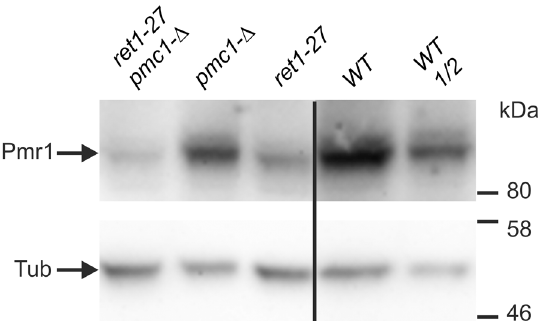
Fig 6. Effect of inactivation of PMC1 on the level of Pmr1 in the ret1-27 mutant strain and in the strain bearing the RET1 wild-type allele. Proteins from cell lysates were resolved by SDS PAGE and transferred to nitrocellulose membrane, which was then divided in two parts at the level of the 80 kDa marker band. The upper part was stained with antiserum against H . polymorpha Pmr1, while the lower part was stained with antibody against tubulin used as a loading control. ret1-27 pmc1- Δ , the 64MA70QA- Δ pmc strain; pmc1- Δ , the 64MA70Q-RET- Δ pmc strain; ret1-27 , the 64MA70QAL strain; WT and WT 1/2, undiluted and two-fold diluted sample of the 64MA70QL-RET strain,